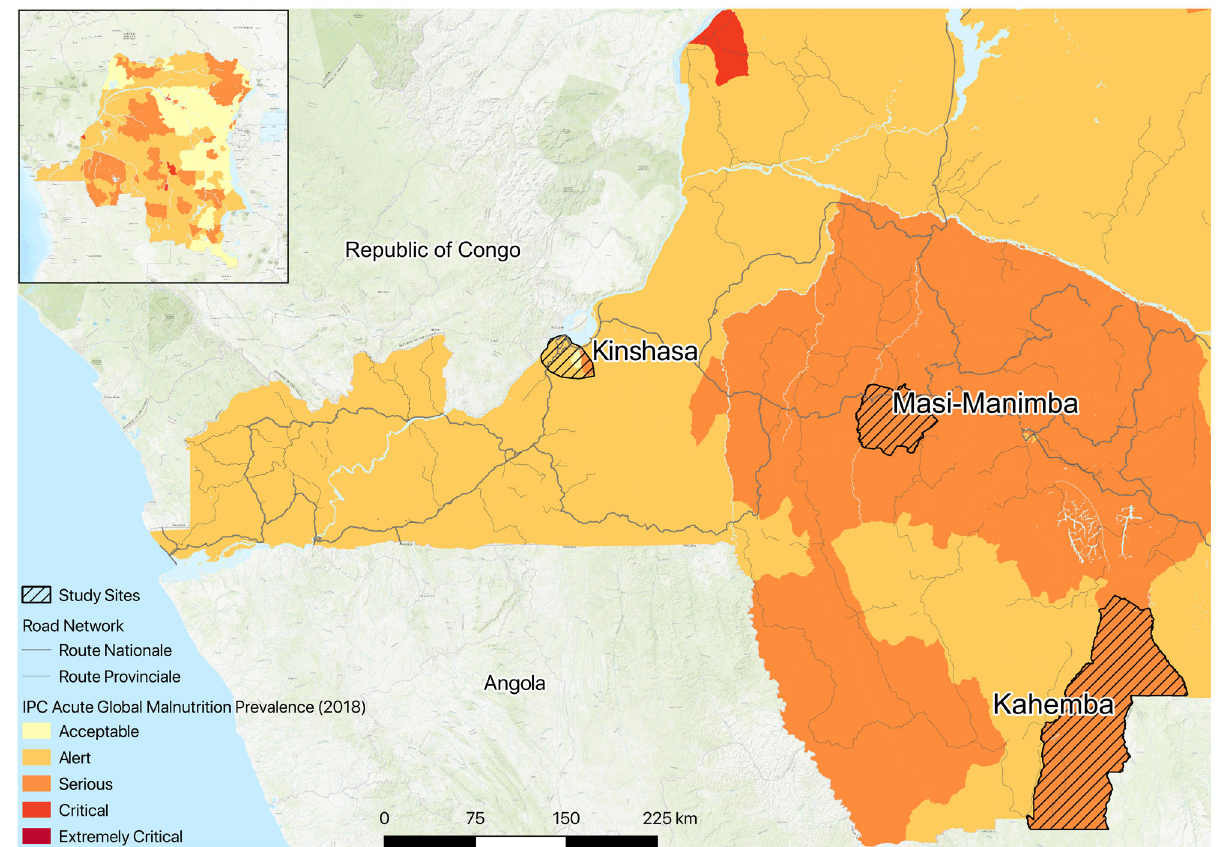
Fig. 1 Map of DR Congo highlighting sampling locations and food insecurity. Sampling locations and summary of study populations from South West DRC that includes the urban capital of Kinshasa ( n = 30, age = 8.7 ± 1.66, 15 F, 15 M), rural regions in Masi-Manimba ( n = 30, age = 9.9 ± 2.32, 15 F, 15 M), and 2 Konzo prone villages in Kahemba (Unaffected Low Prevalence Zone (ULPZ), n = 30, age = 7.93 ± 2.32, 15 F, 15 M) (Konzo Low Prevalence Zone (KLPZ), n = 30, age = 8.33 ± 2.67, 12 F, 18 M) (Unaffected High Prevalence Zone (UHPZ), n = 30, age = 9.03 ± 2.03, 15 F, 15 M) (Konzo High Prevalence Zone (KHPZ), n = 30, age = 9.63 ± 2.31, 12 F, 18 M). Using qGIS 3.8 software, we generated the map illustrating the current status of food insecurity